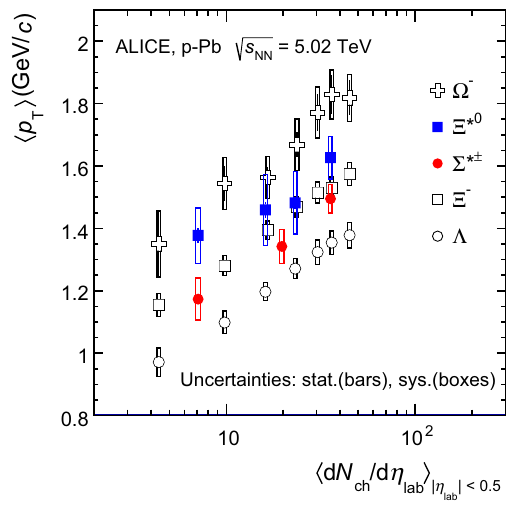
Fig. 6 Mean transverse momenta (cid:3) p T (cid:4) of (cid:9) , (cid:4) − , (cid:3) ∗± , (cid:4) ∗ 0 and (cid:7) − √ s NN = 5 . 02 TeV as a function of mean charged- in p–Pb collisions at particle multiplicity density (cid:3) d N ch /d η lab (cid:4) , measured in the pseudora- pidity range | η lab | < 0.5. The results for (cid:9) , (cid:4) − and (cid:7) − are taken from[10,14,24].Statisticalandsystematicuncertaintiesarerepresented as bars and boxes , respectively. The (cid:7) − and (cid:4) − points in the 3rd